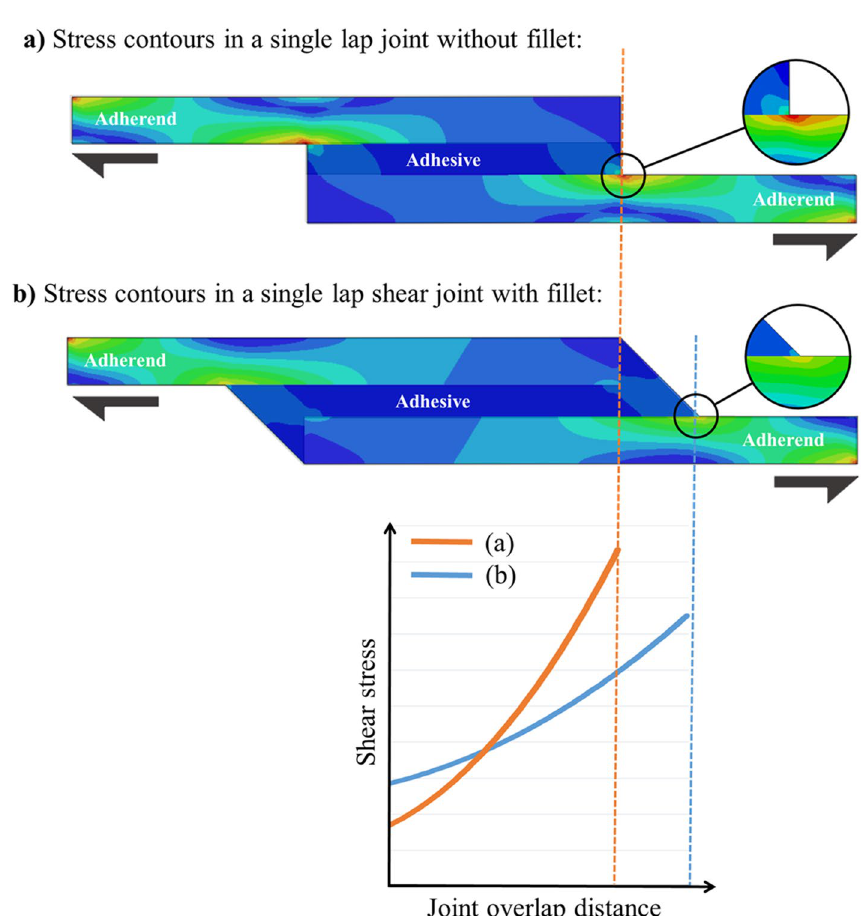
Fig. 9 The effect of fillet pres- ence on shear stress in a single lap